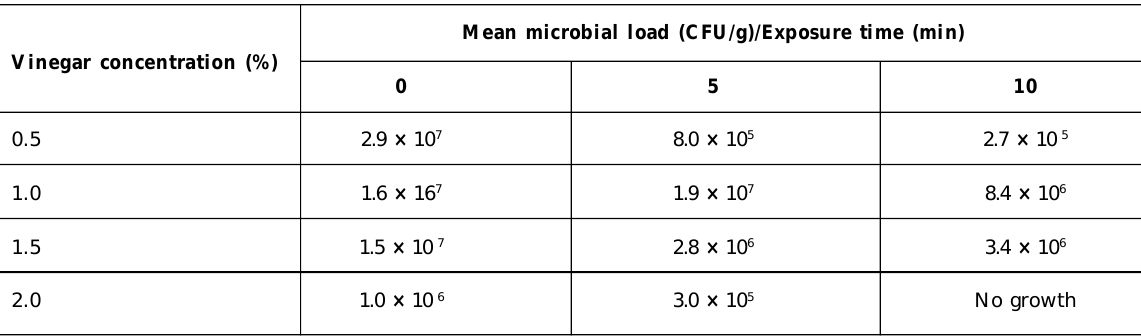
Vinegar concentration